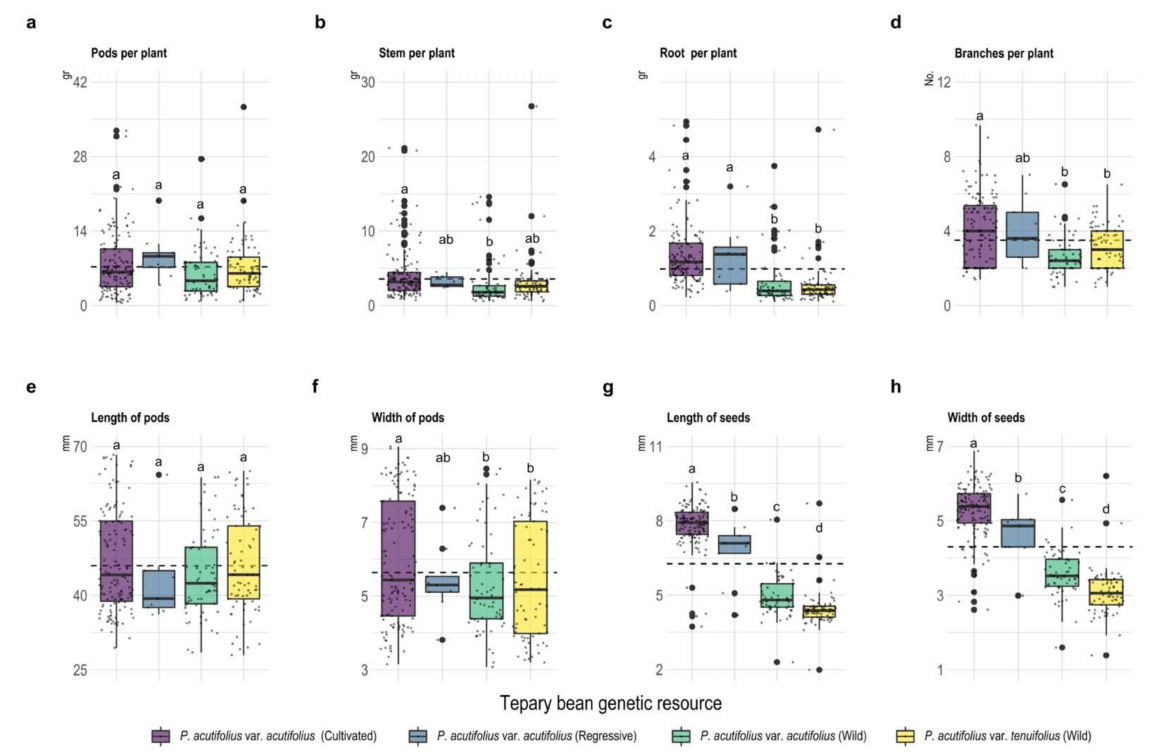
Figure 1. Box plots of the scatter plot for agronomic characteristics at the plant ( a – d ), pod ( a , e , f ), and seed ( g , h ) levels among the tepary bean genetic resource. Dotted line means the overall mean for each variable. Different letters between tepary bean genetic resource indicate different means ( p < 0.05).